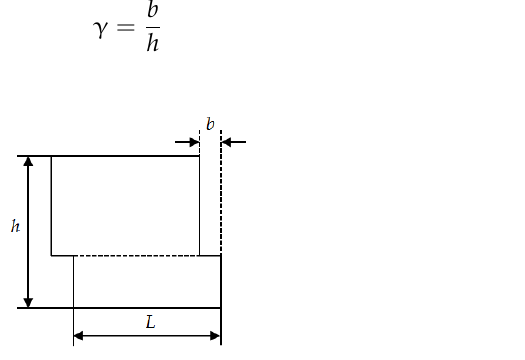
h: the width of element; L : the length of